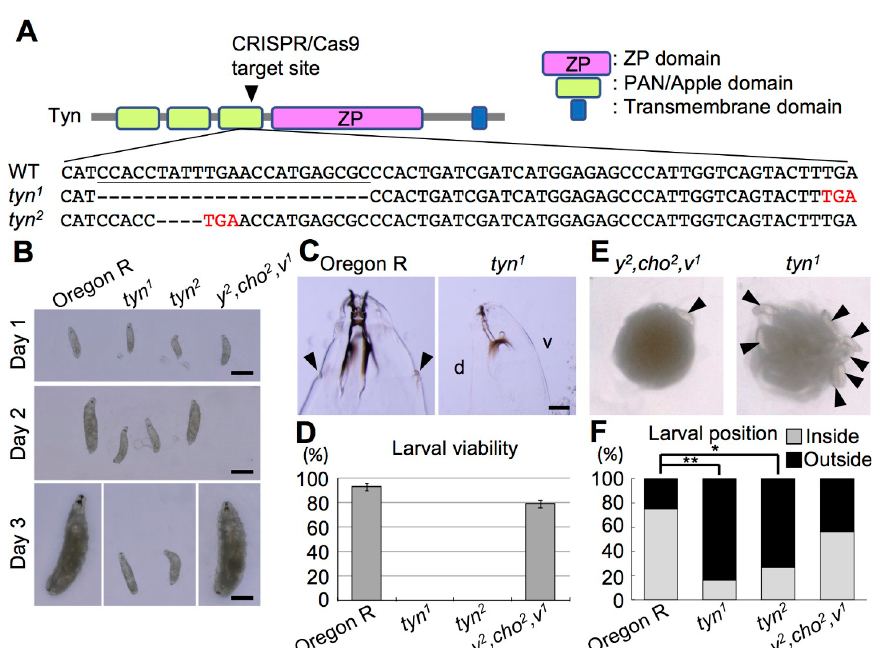
Fig 1. tyn mutants and their gross phenotypes. (A) Tyn protein structure and tyn DNA sequence of the region including the CRISPR/Cas9 target site. Tyn has 3 PAN/Apple domains, a ZP domain, and a transmembrane domain. The target site is indicated by an arrowhead in the diagram, and the sequence is underlined. tyn 1 and tyn 2 contained 23- and 4-base deletions respectively, which resulted in early stop codons (red letters). (B) Larval body size for each genotype. Day 1 means ~24 hours after hatching. On days 2 and 3, the tyn mutants remained small, while control larvae (Oregon R and y 2 , cho 2 , v 1 ) grew larger. Scale bar: 500 μ m. (C) On day 3, the tyn 1 mutant larvae lacked anterior spiracles, while those of Oregon R were obvious (arrowheads). Scale bar: 50 μ m. (D) Larval viability of each genotype. n = 100 for each. (E) Photographs of larvae with yeast paste. Arrowheads indicate larvae that stayed at the periphery of the yeast paste without entering it. In the left panel, there were 5 larvae within the food. The quantified data are shown in (F). n = 15–20 for each. �� P < 0.01, � P < 0.05 by Fisher’s exact test with Benjamini & Hochberg correction.